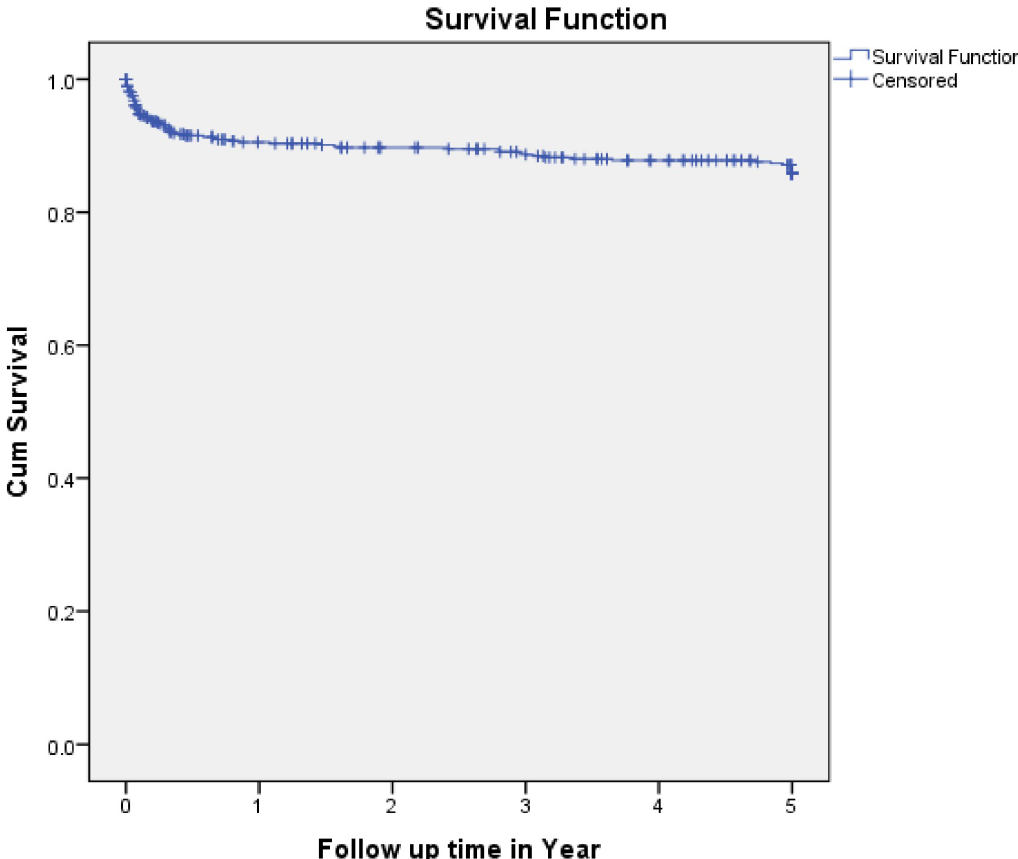
Fig 3. Kaplan-Meier EPTB free survival curves among HIV positive patients in Addis Ababa, Ethiopia, from 01 January 2013 up to 31 December 2018 (n = 566).